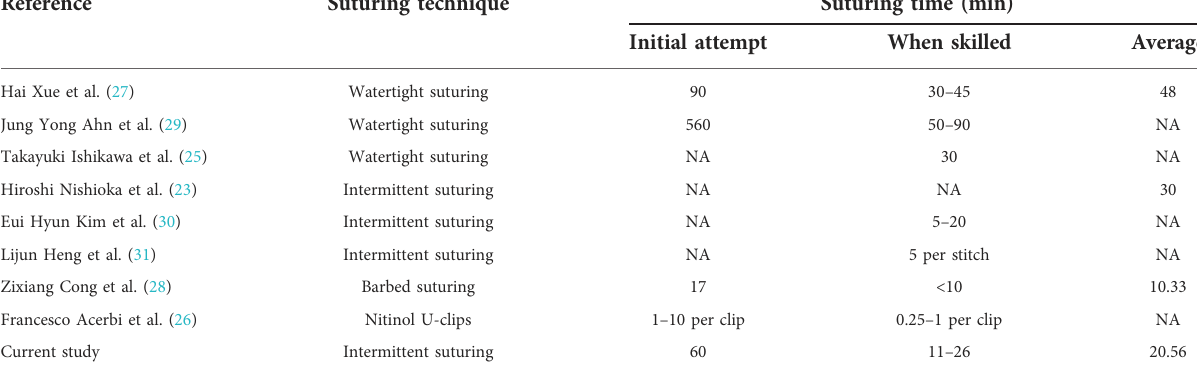
TABLE 4 Time of dural suturing in endoscopic transsphenoidal